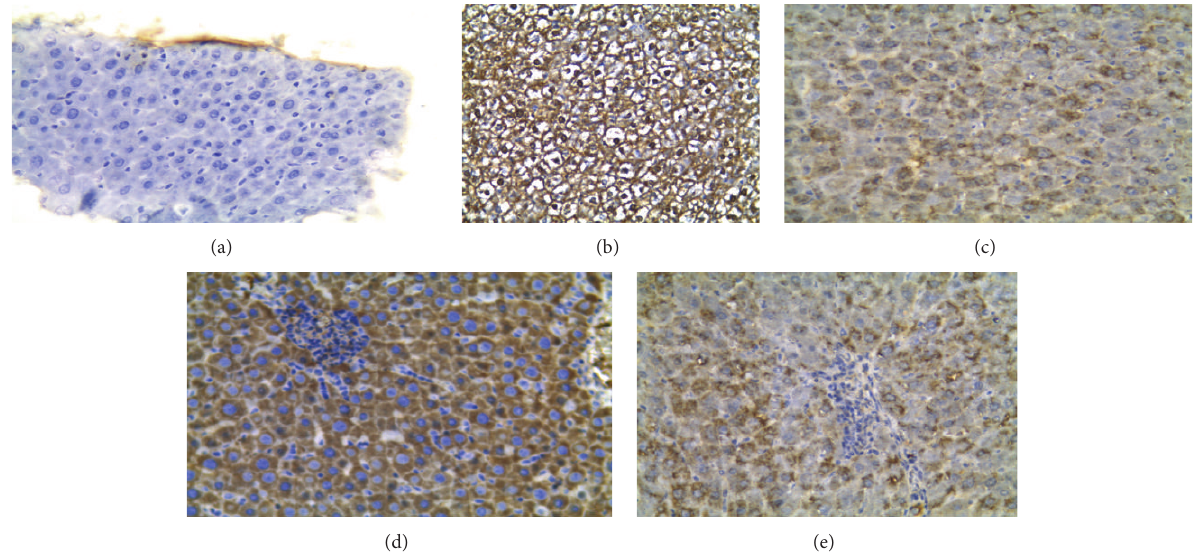
Figure 3: Caspase 3 immunohistochemical staining of apoptosis: immunohistochemical staining of Caspase 3 in liver tissues (PAP × 200) of (a) control animals showed negative (−) caspase 3 stain. (b) Highly positive (+ + + +) for caspase 3 as in EE/CPZ group or fenofibrate plus GW6471 group. (c) Mild caspase 3 positivity (+) as in fenofibrate, bezafibrate, gemfibrozil, and UDCA groups. (d) Moderate cytoplasmic caspase 3 positivity (+ + +) as in bezafibrate plus GW6471. (e) Moderate positivity (++) in the cytoplasmic (granular) stain for caspase 3 as in gemfibrozil plus GW6471